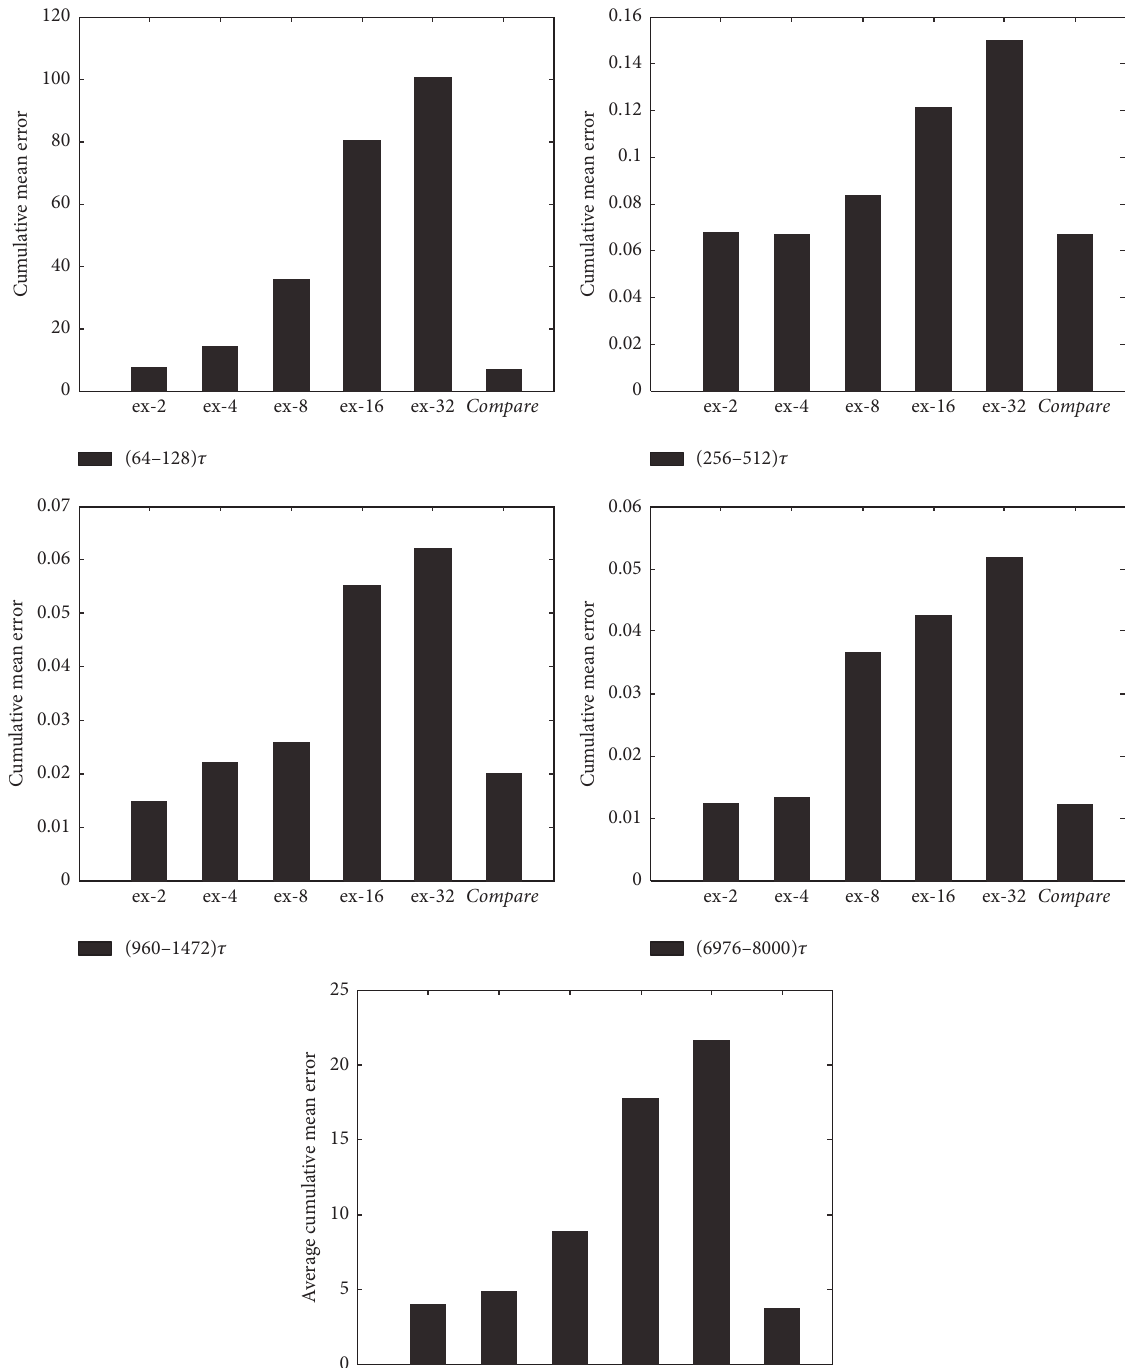
Figure 13: Cumulative mean errors during four time intervals (64–128) 𝜏 , (256–512) 𝜏 , (960–1472) 𝜏 , and (6976–8000) 𝜏 and final average